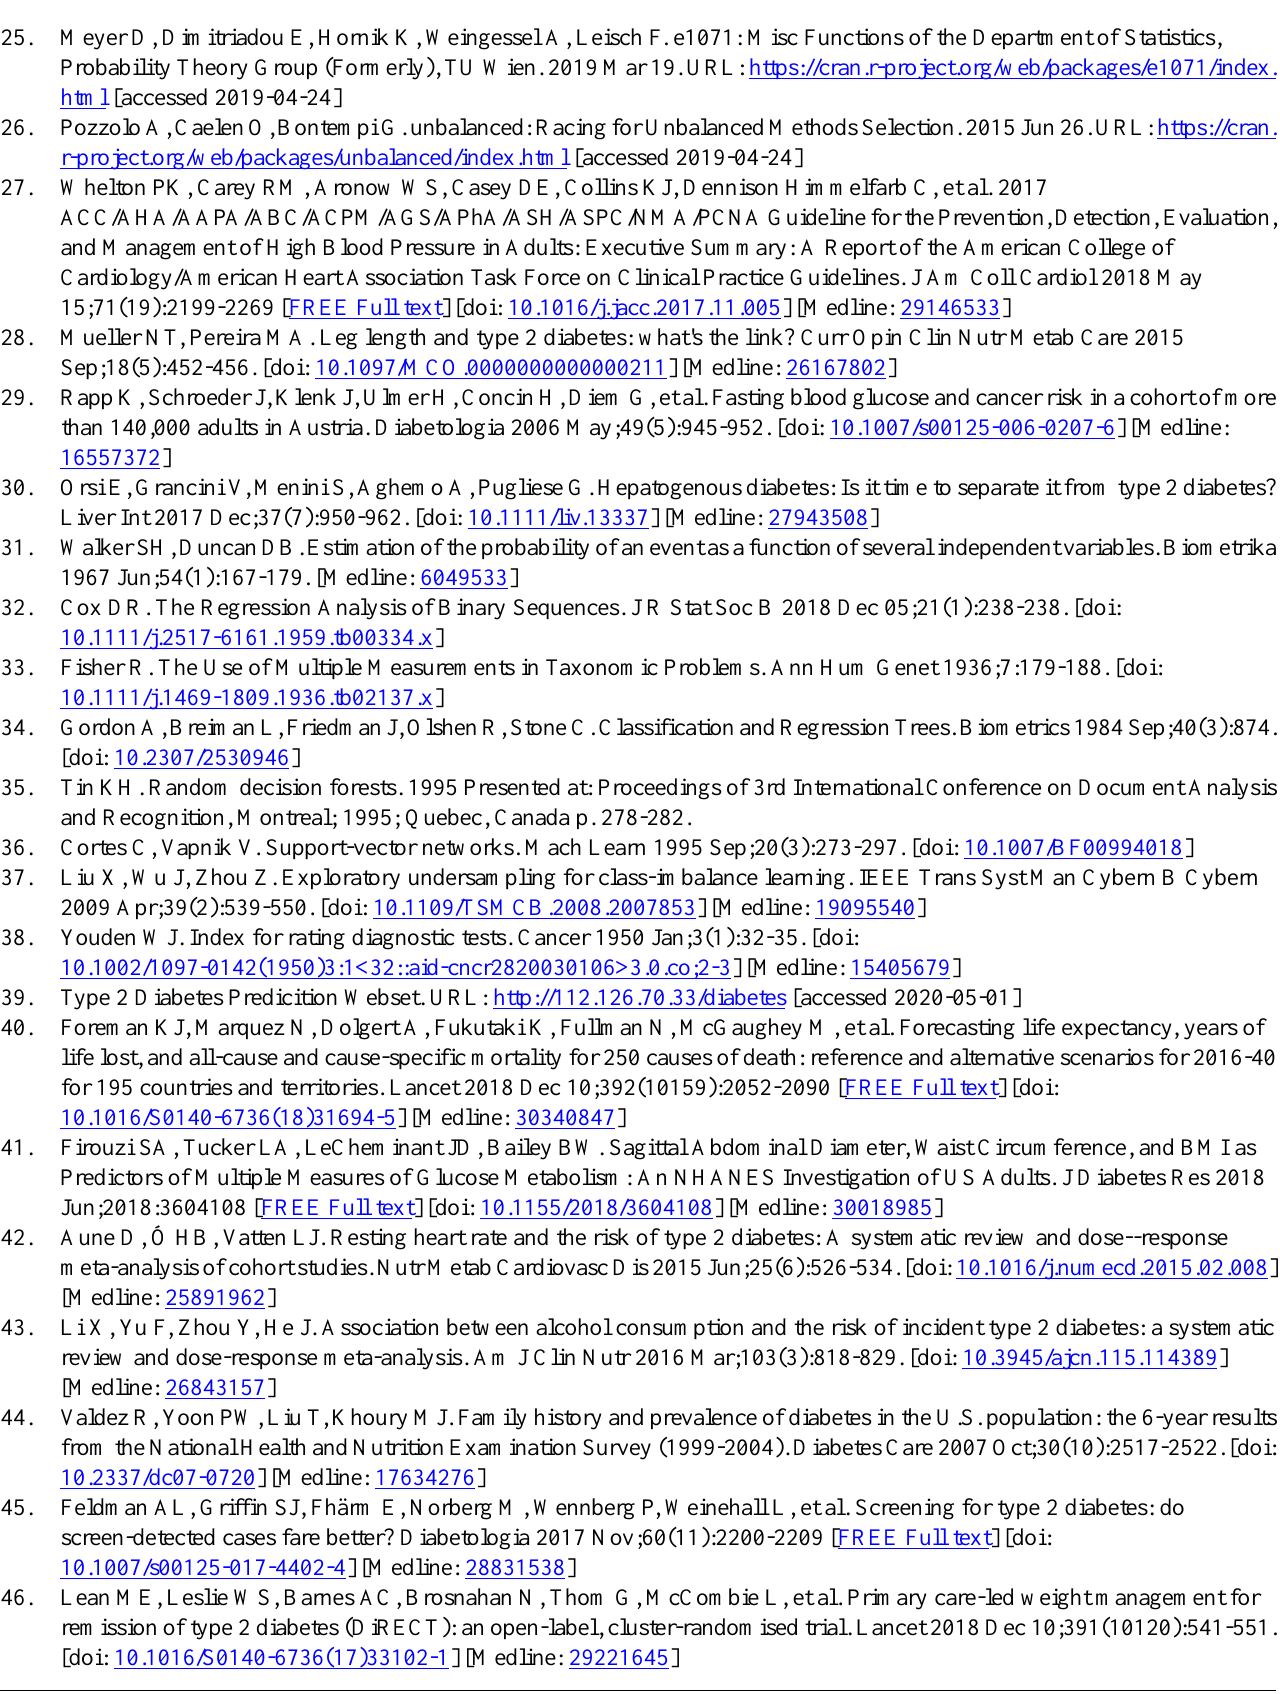
Abbreviations AUC: area under the